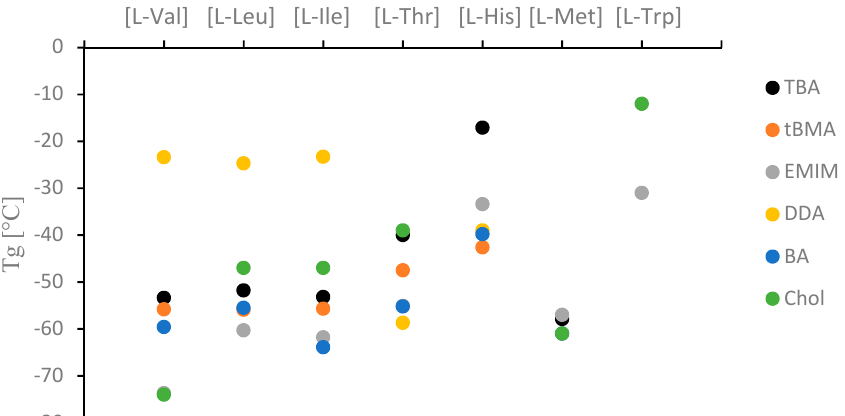
Figure 10. Plot of glass transition temperatures (T g ) vs. amino acids.